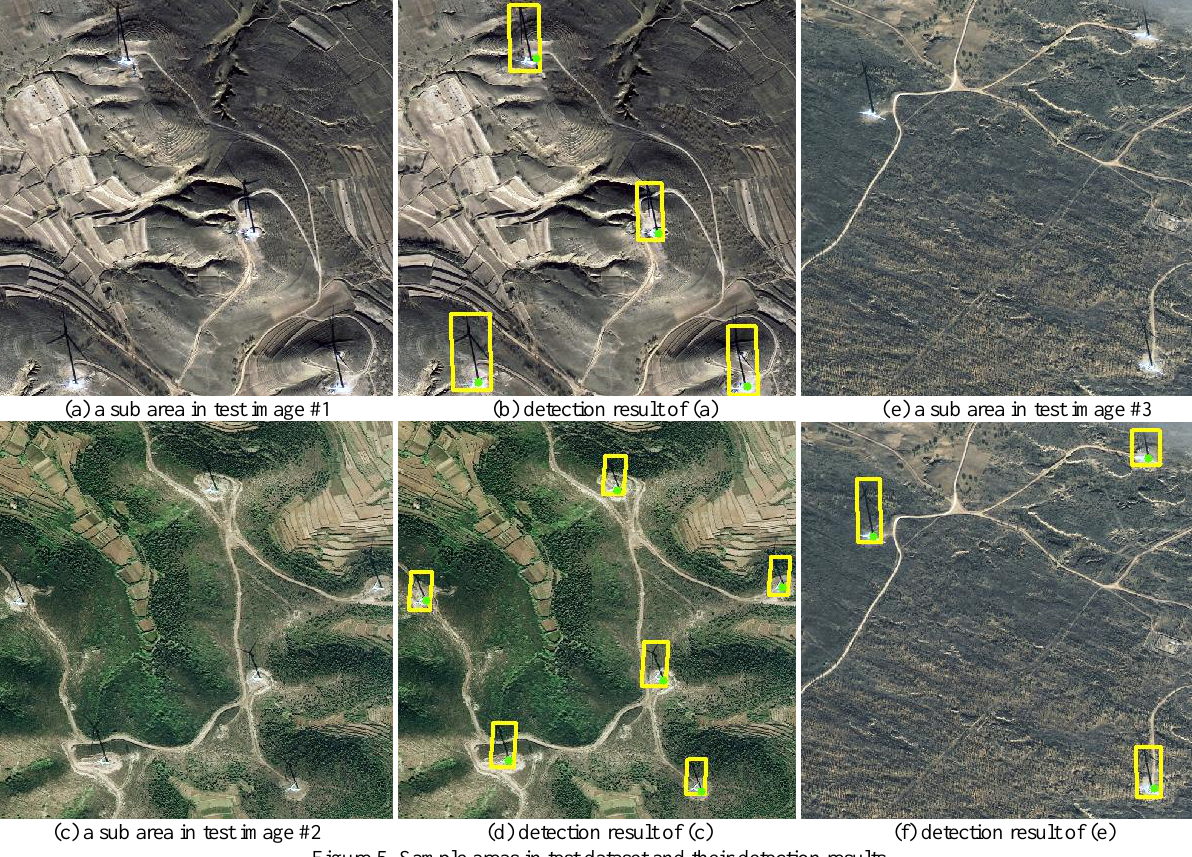
Figure 5. Sample areas in test dataset and their detection